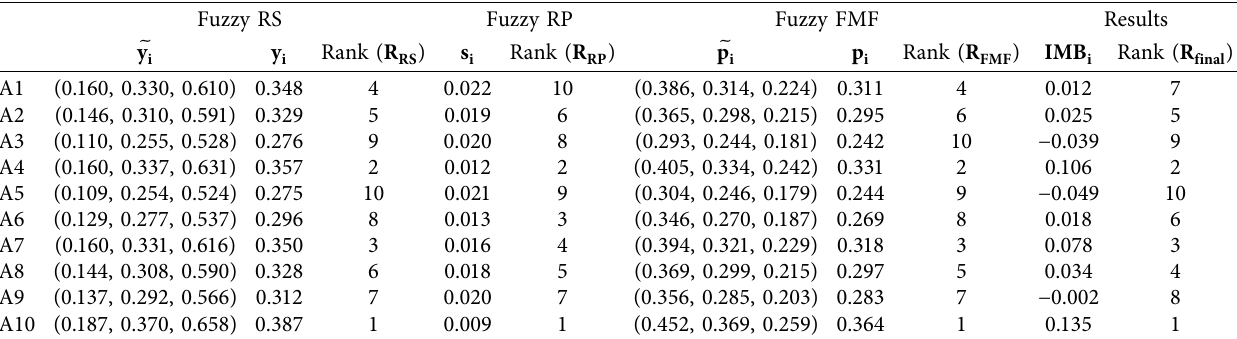
Table 10: HF-AHP-MULTIMOORA results and